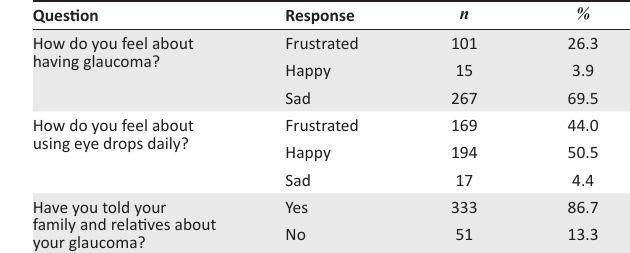
TABLE 3: Patients’ responses to attitudinal questions on glaucoma in the uThungulu Health District,